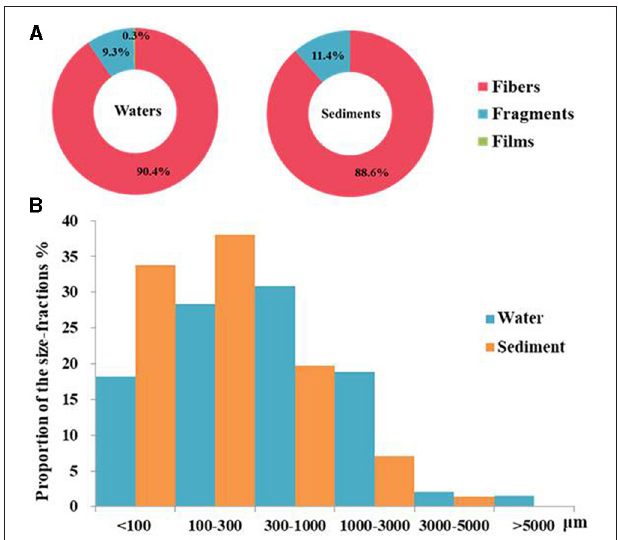
FIGURE 3 | The shape types (%) (A) and the size fractions (%) (B) of the microplastics in water and the sediments of the Baltic